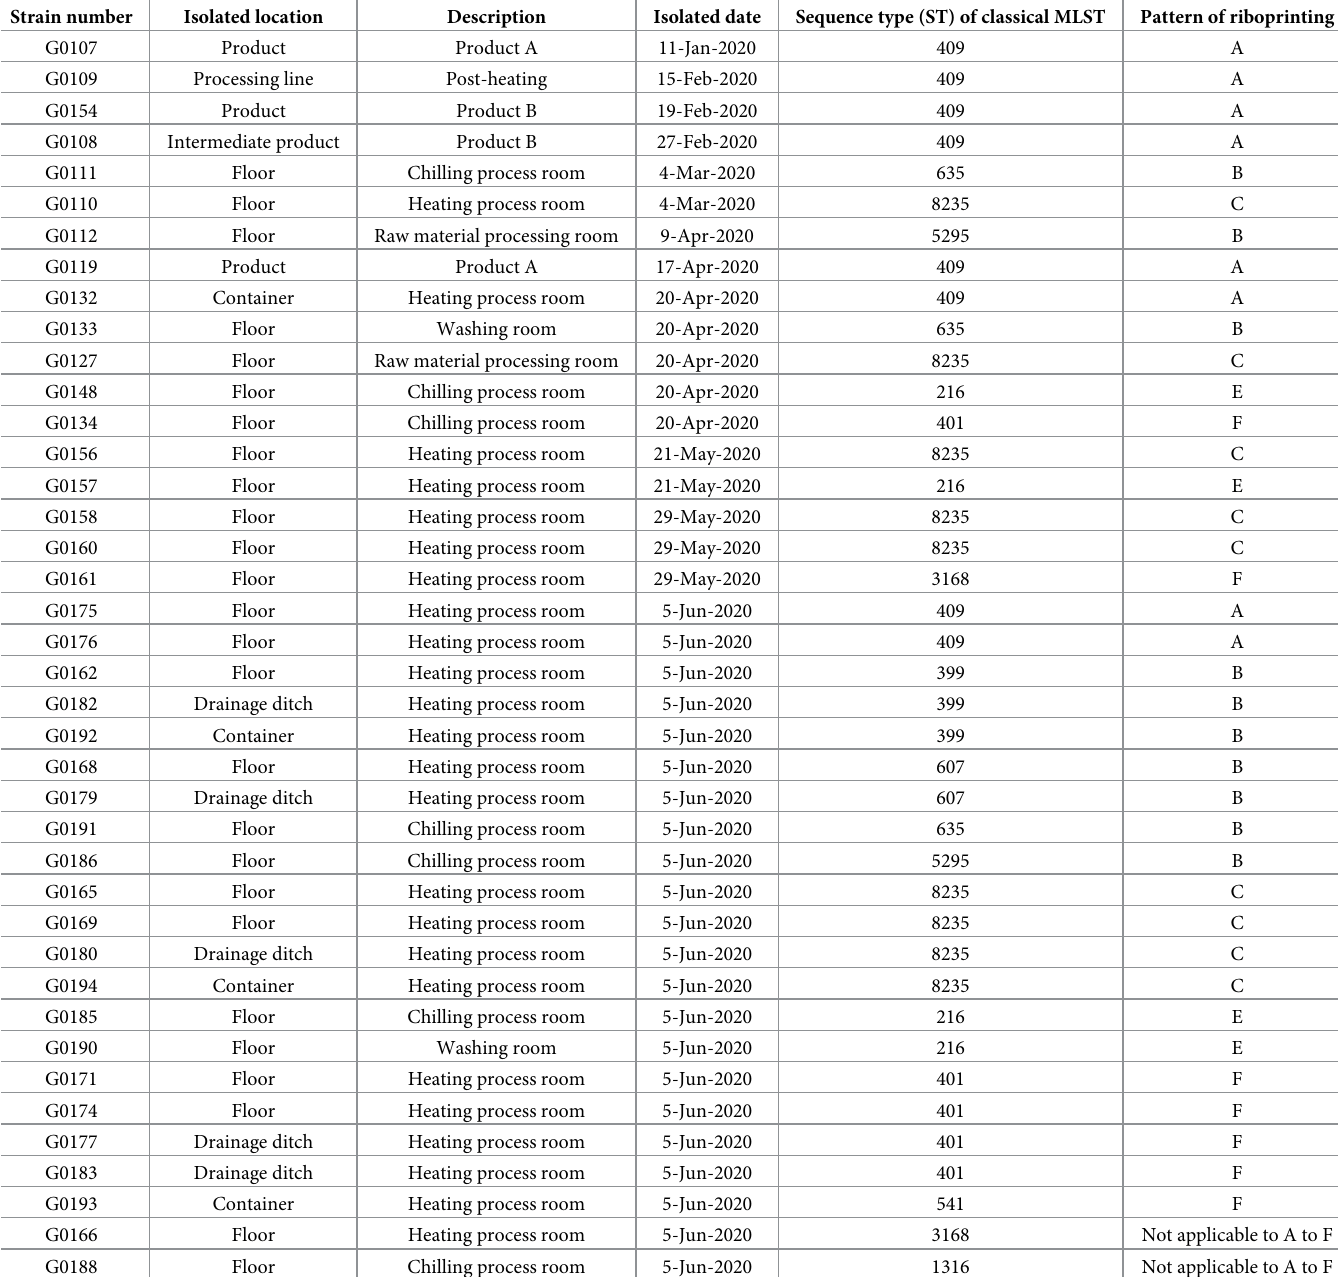
Table 2. Detailed information regarding the 40 E . coli strains used for subtyping and the results of classical MLST and